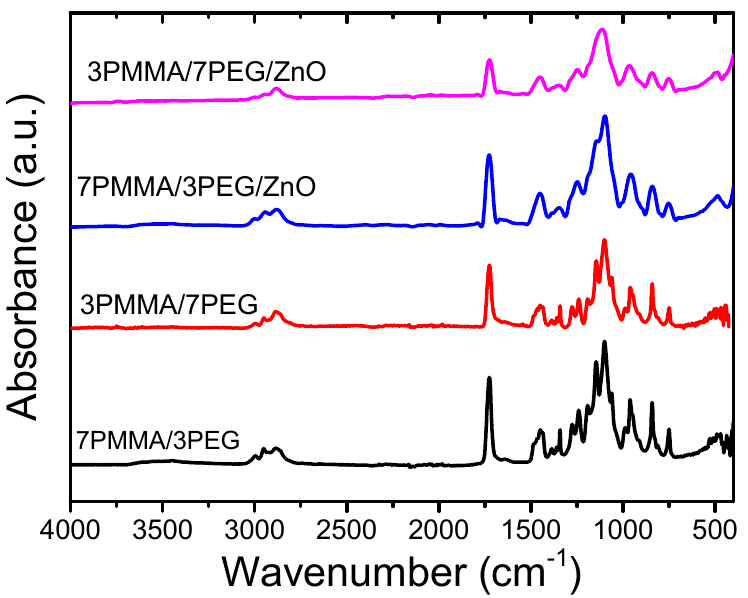
Figure 4. FTIR spectra of the 7PMMA/3PEG and 3PMMA/7PEG polymer blends and of the 7PMMA/3PEG/ZnO and 3PMMA/7PEG/ZnO polymer nanocomposites.